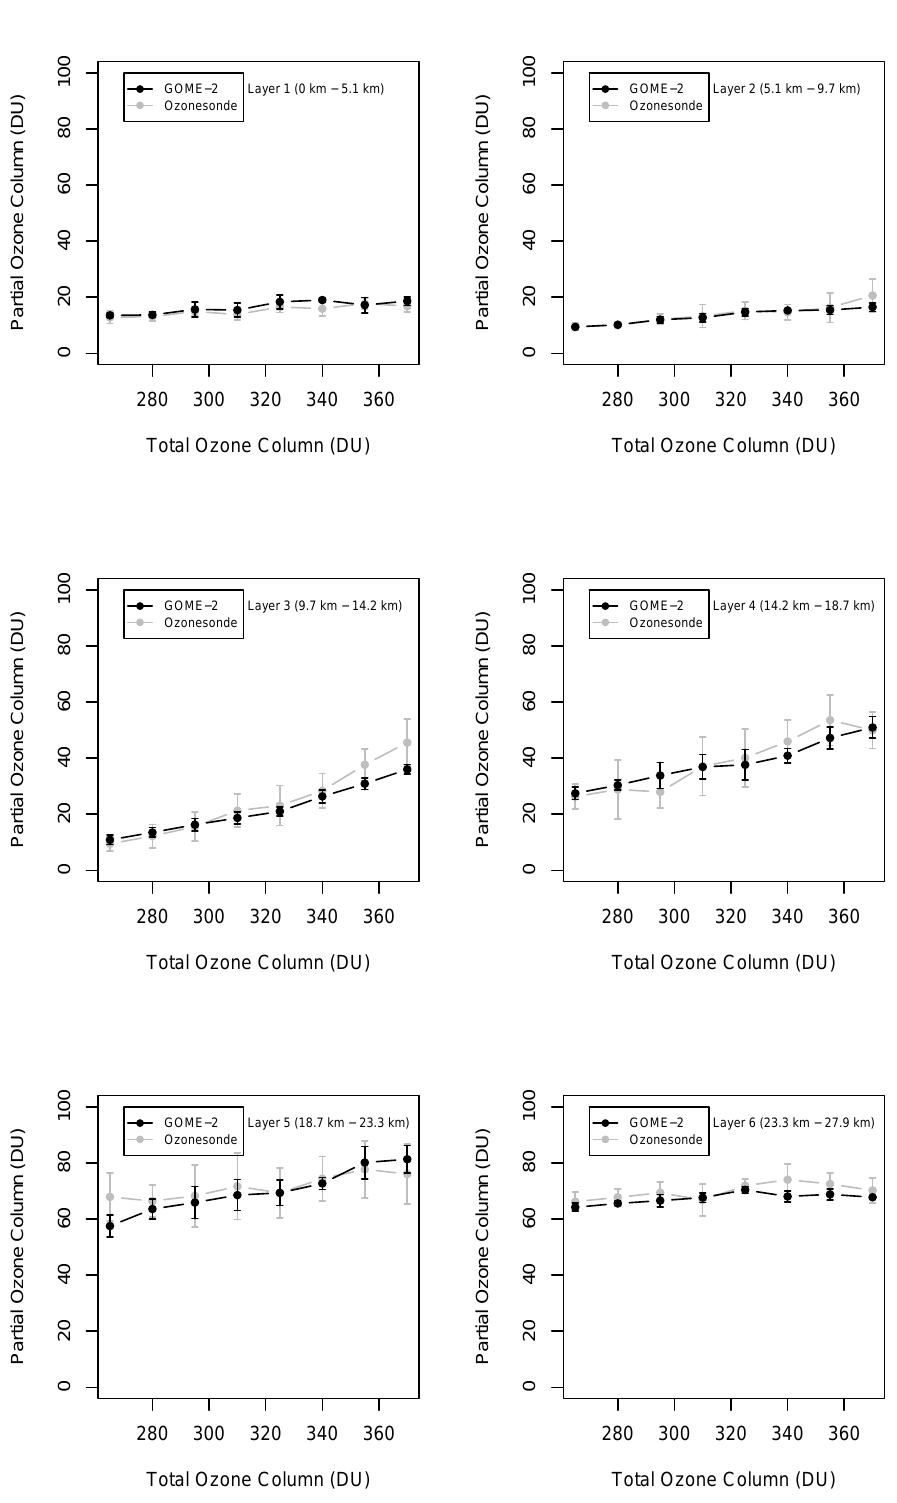
Fig. 7. Partial ozone amounts for 6 layers of the TOMS V8 climatology as a function of ground-based total ozone at Madrid. The grey points represent the mean values of ozonesonde measurements for each Brewer ozone interval, and the black points represent the corresponding mean ozone amount from the TOMS V8 climatology used as a priori in the GOME-2/MetOp ozone retrieval. In both cases, the error bars represent one standard